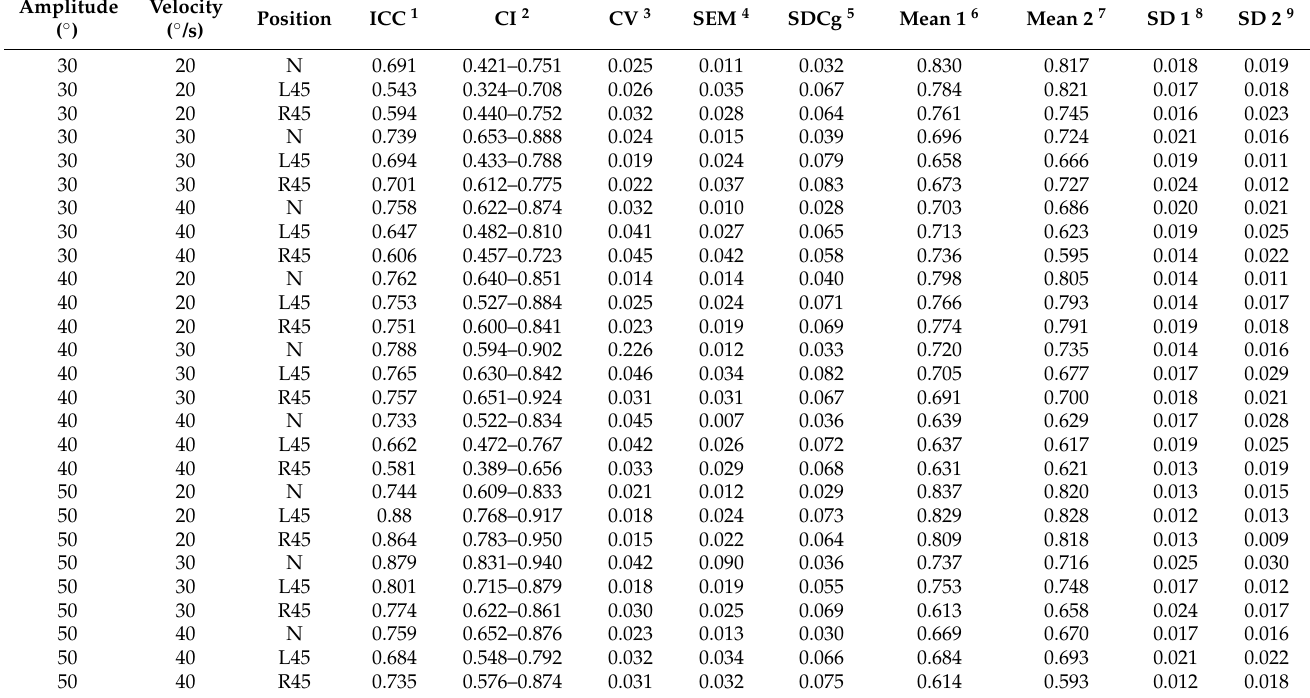
Table 2. Average gain reliability for each task in chronic neck pain